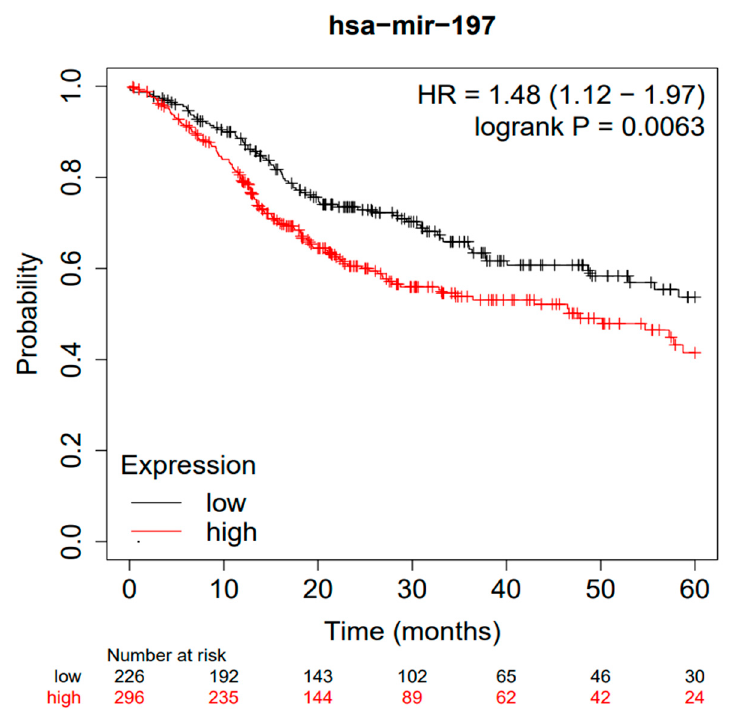
Figure 3. Kaplan–Meier curves according to the miR-197 expression levels for overall survival in patients with HNSCC (TGCA cohort analysis), with a follow-up period of 60